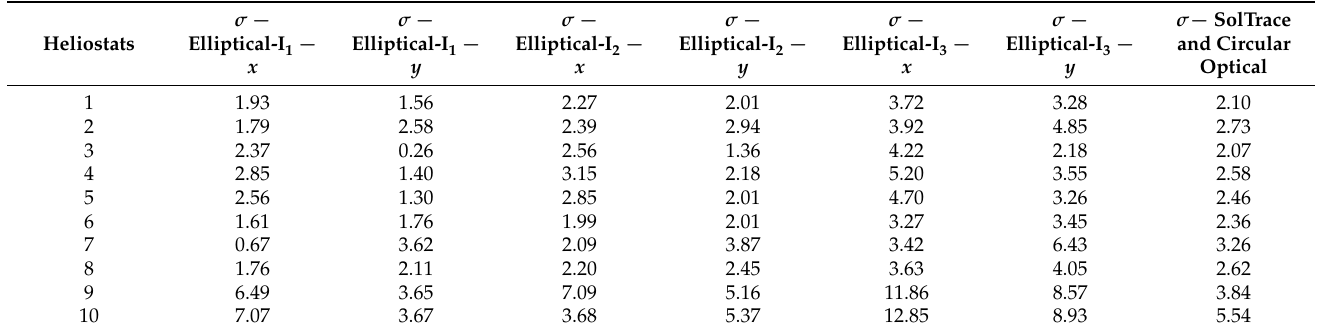
Table 3. Optical errors of ten heliostats calculated by different models (unit: mrad).